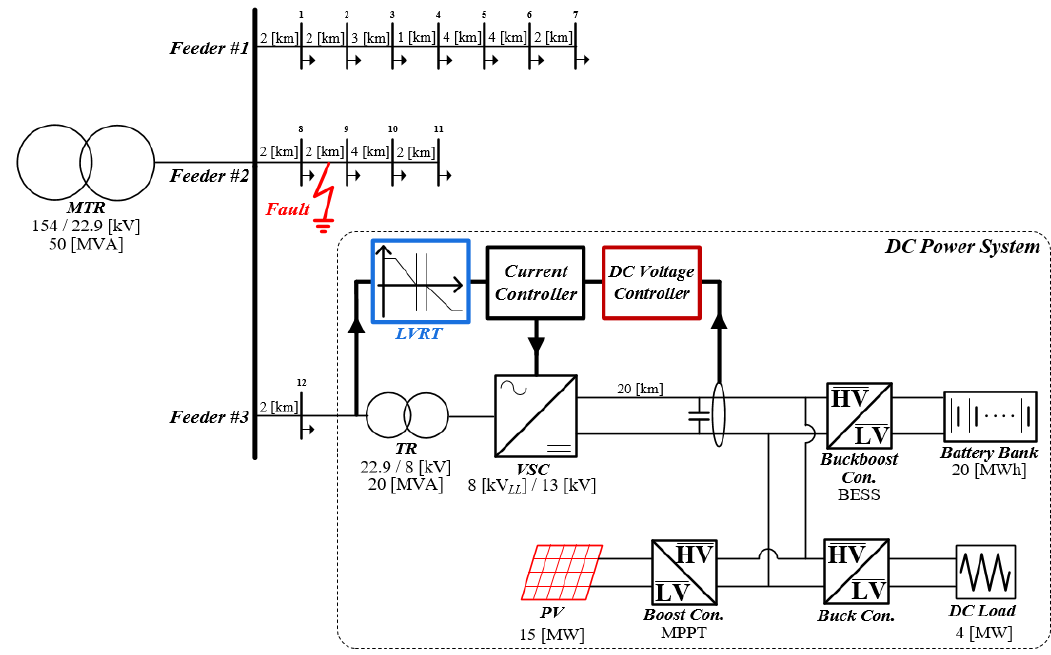
Figure 2. Detailed Configuration of Power Distribution System connected with DC Power System.